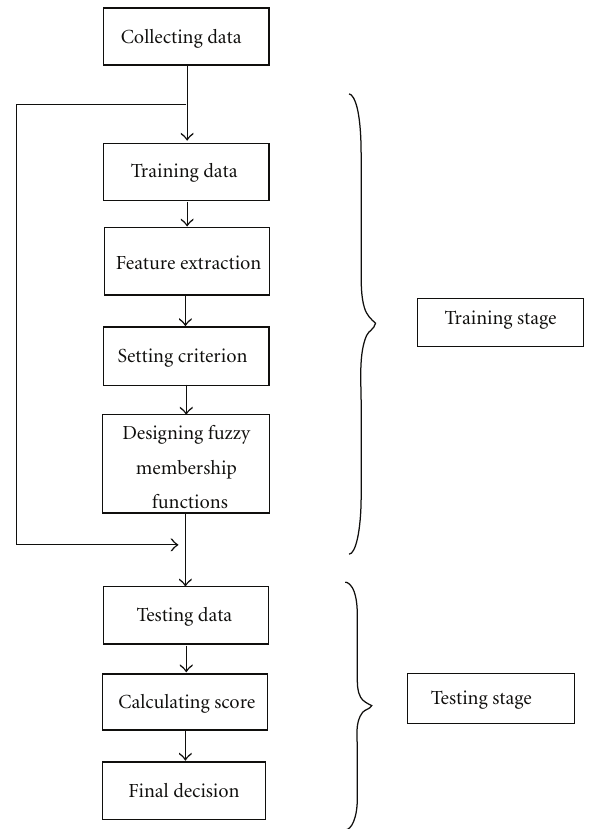
Figure 1: Schematic of the proposed algorithm. The proposed algorithm consists of two stages: training and testing. In the training stage 25 subjects’ data are used to extract features to classify patients from healthy subjects. In the test stage, subjects will be divided into three predefined groups of healthy, high risk, and patient, based on their assigned